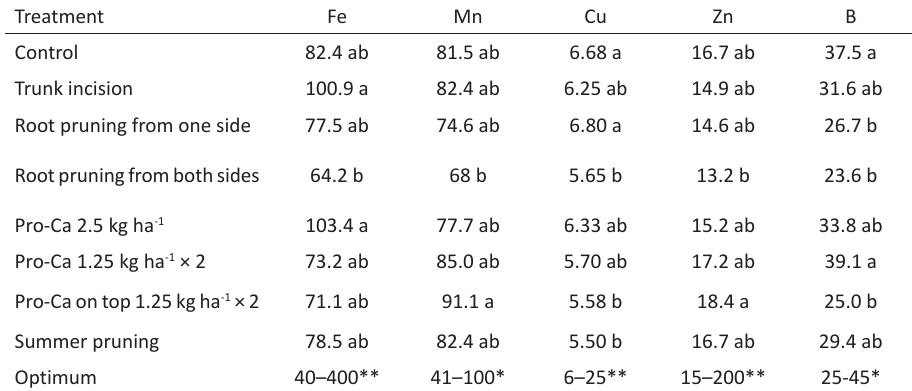
Table 6. Effect of growth control technologies on leaf trace element content (mg kg -1 ), average of